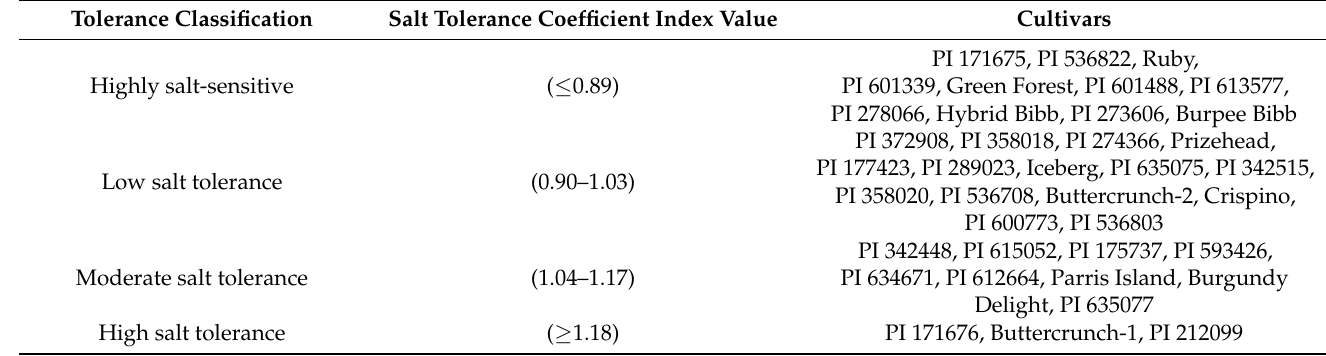
Table 15. Tolerance classification (TC) of lettuce cultivars into various salt-tolerance groups (highly salt-tolerant, moderately salt-tolerant, low salt-tolerant and highly salt-sensitive) based on the Total salt tolerance coefficient index (STCI). Each STCI value is the sum of individual salt tolerance coefficient index values of three morphological and four biological